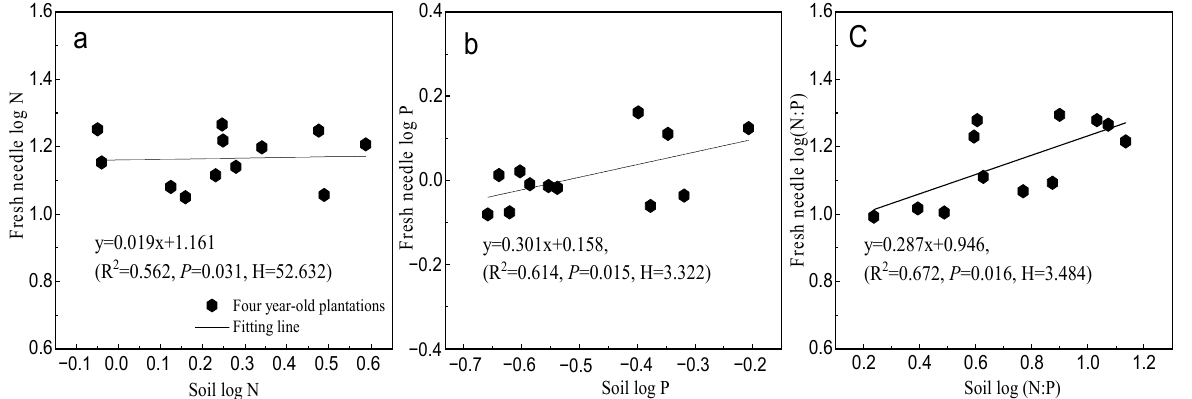
Figure 4. Line regression relationships between fresh needle and soil for N concentrations ( a ), P concentrations ( b ), and N:P ratios ( c ) along the chronosequence of P. massoniana plantations.